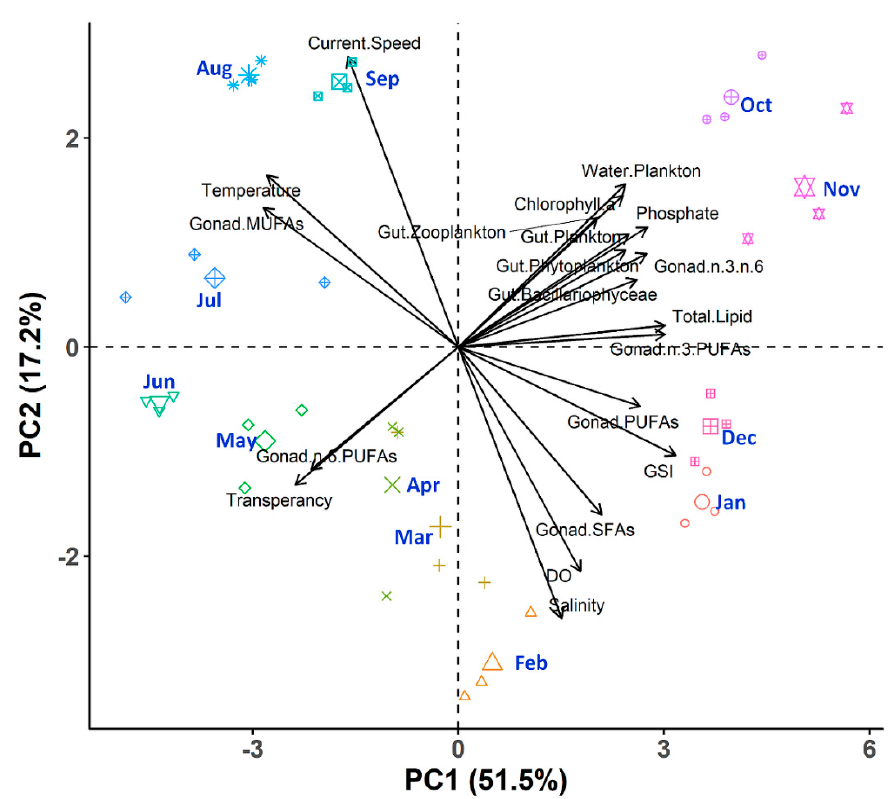
Figure 13. Biplot of principal component analysis (PCA) showing the relationships among the environmental factors, ingested gut plankton, lipids, and fatty acid content of gonads and GSI of green mussel Perna viridis collected from the coastal waters of Bangladesh for the period of November 2017 to October 2018. The analysis consists of 36 observations and the 20 most important variables